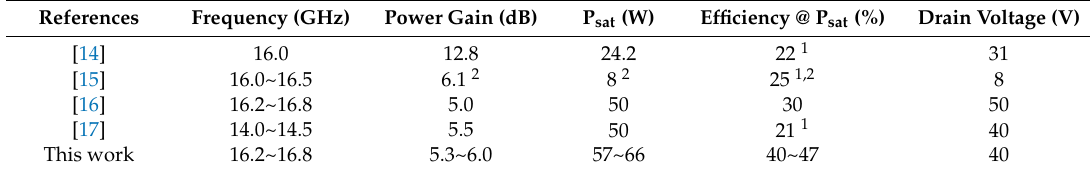
Table 2. Comparison of our work and previously published Ku-band GaN HEMT power amplifiers.